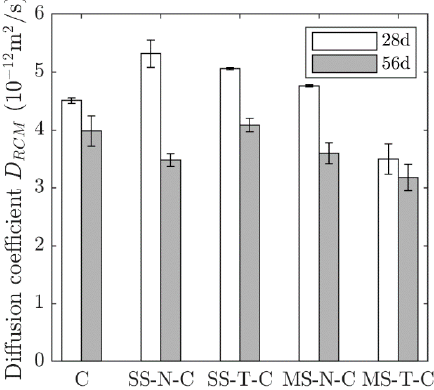
Figure 6. Chloride ion diffusion coefficient D RCM .